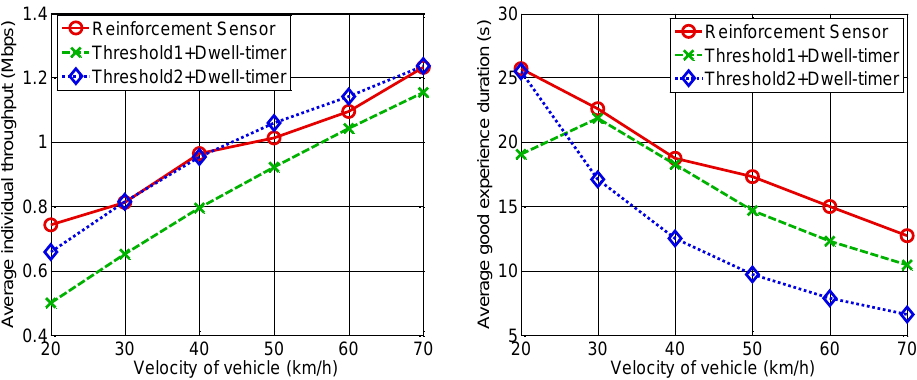
Figure 12. Average individual throughput and good experience duration vs. velocity of vehicle (arrival rate = 0.5